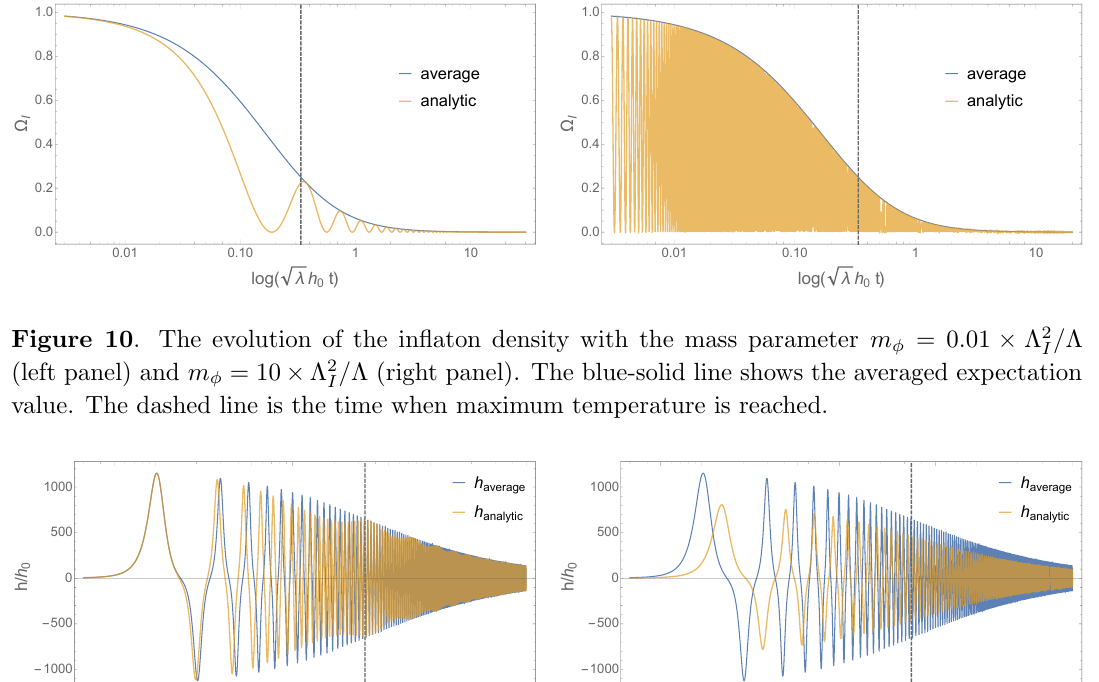
Figure 11 . The evolution of Higgs with the mass parameter m (cid:30) = 0 : 01 (cid:2) (cid:3) 2 m (cid:30) = 10 (cid:2) (cid:3) 2 = (cid:3) (right panel). The blue-solid line shows the result from a smoothed in(cid:13)aton I density. The dashed line is the time when maximum temperature is reached.